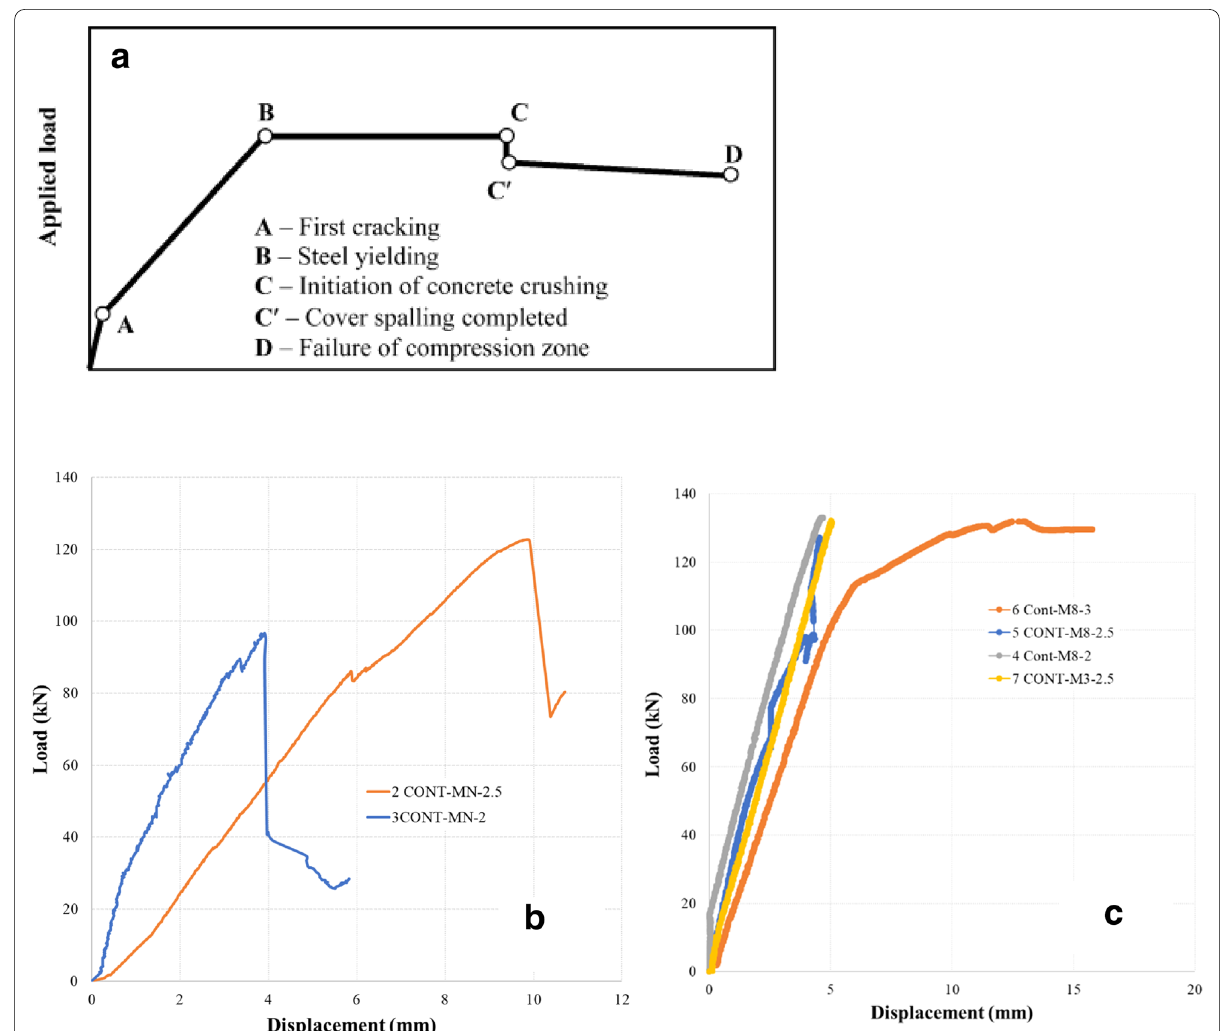
Fig. 4 Load–displacement curves for ( a ) Idealized reinforced HSC beam [22]; ( b ) group 1 and ( c ) group 2 tested